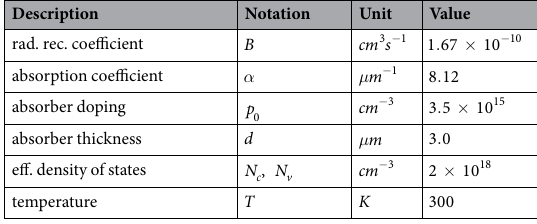
Table 1. Parameters used for simulating PL